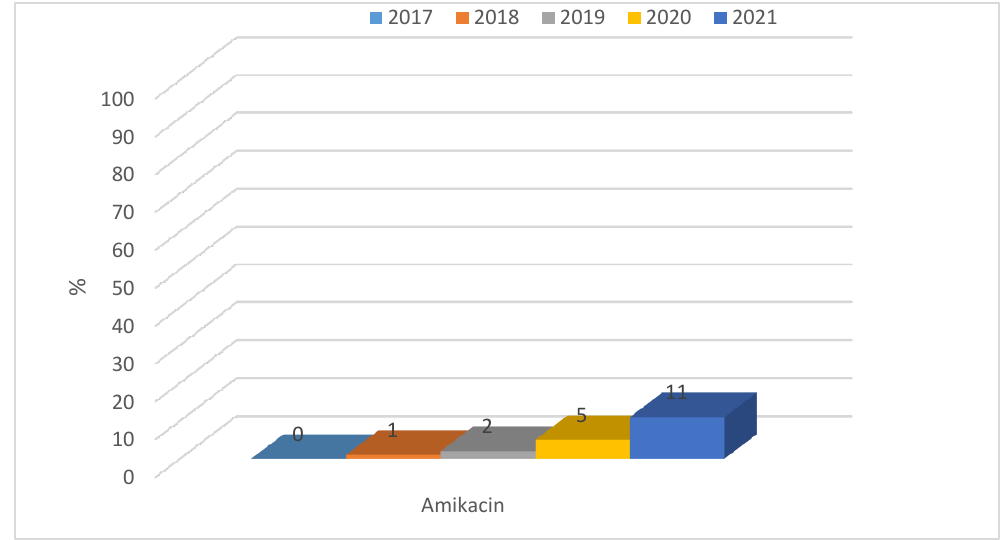
Figure 10. Percentage of quinolone-resistant E. coli ESBL(+) strains.